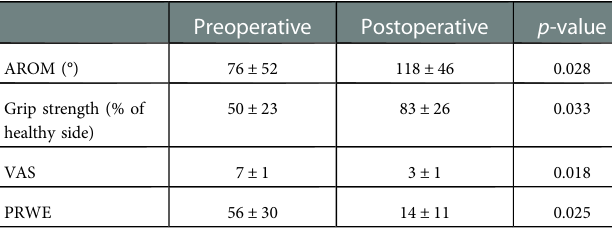
TABLE 1 Clinical outcomes of pre- and post-operation.